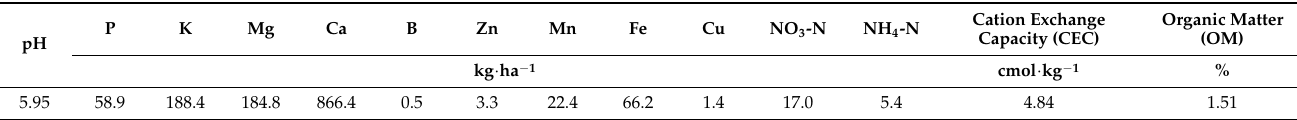
Table 1. Soil analysis from the experimental field (0–40 cm depth) at the Dempsey Farm, University of Georgia, Griffin, GA. Samples were taken in April of 2016 before any fertilizer treatments were applied ( n = 48). pH